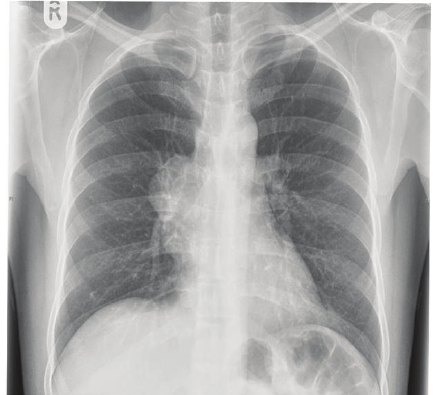
Figure 1: Chest X-ray showing right sided hilar mass.